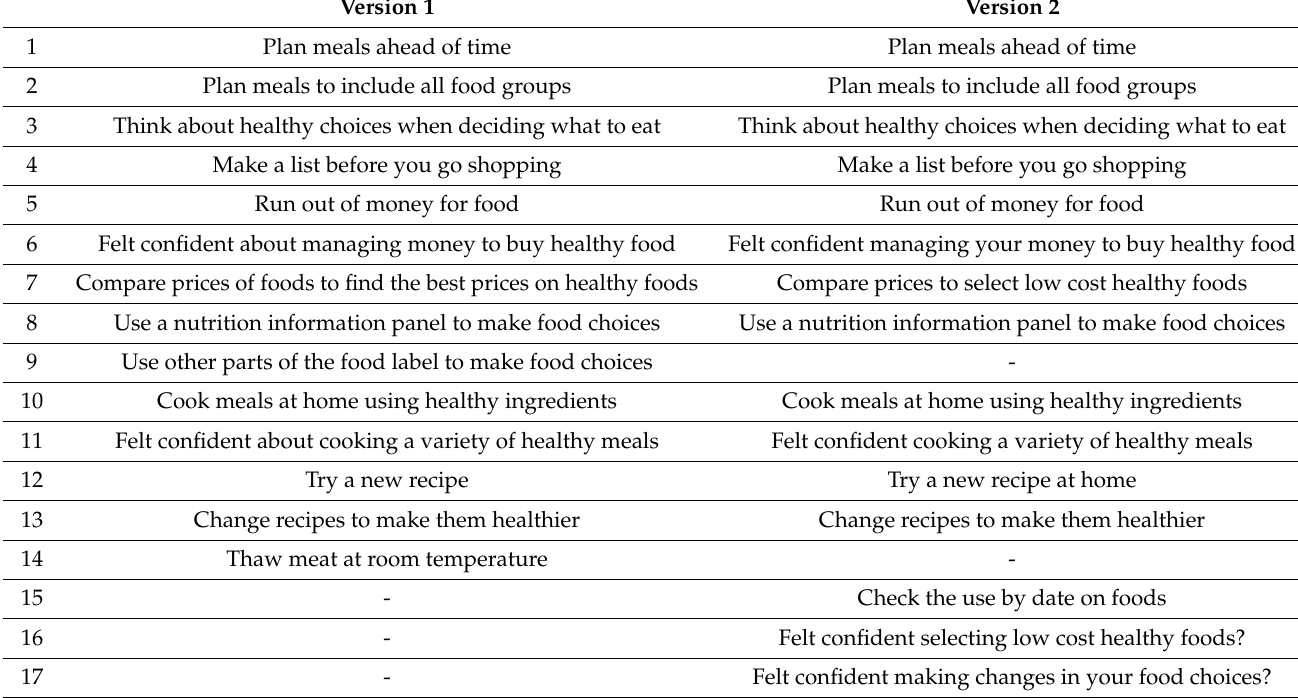
Table 1. Comparison of questions included in the Food Literacy Behaviors Checklist (Versions 1 and